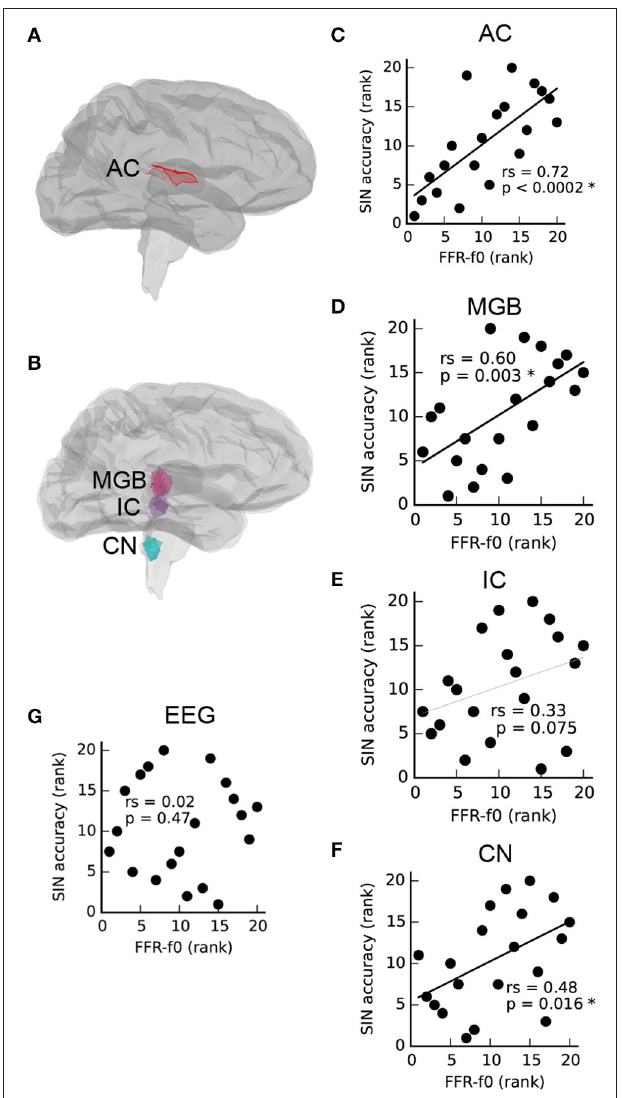
FIGURE 1 | Correlations between FFR-f0 strength and speech-in-noise accuracy (SIN) within regions of interest (ROIs) in the auditory cortex (A,C) , and subcortical areas (B,D–F) as measured with magnetoencephalography (MEG) suggest that better SIN performance is related to better periodicity encoding throughout the auditory system. The FFR measured using electroencephalography at the vertex (Cz) is shown for comparison in (G) . AC, auditory cortex; MGB, medial geniculate body; IC, inferior colliculus; CN, cochlear nucleus. Correlations are calculated using Spearman’s rho